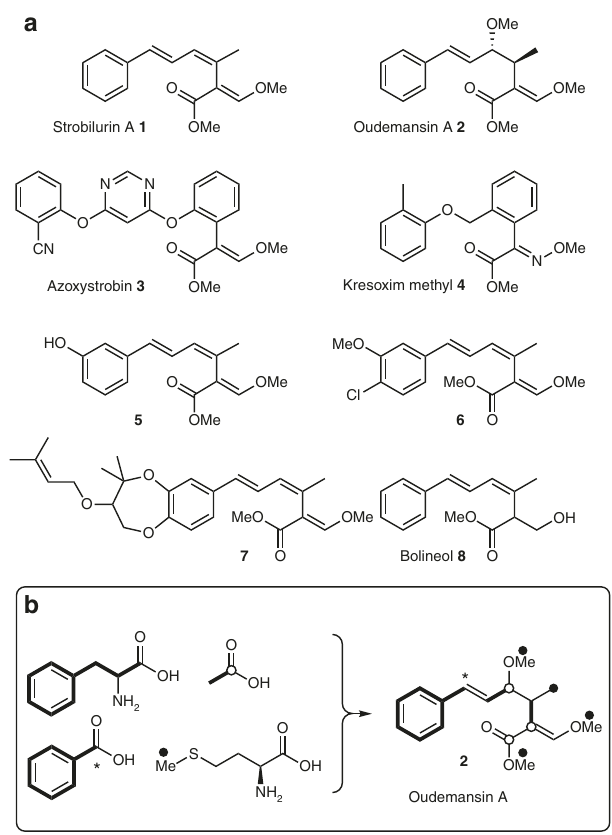
Fig. 1 Structures of key natural ( 1 , 2 , 5 – 8 ) and synthetic ( 3 , 4 ) strobilurins. a Compounds 1 – 3 and 5 – 7 feature the key β -methoxyacrylate toxophore, while 8 is reduced. Compound 4 possesses a chemically similar methoxyiminoacetate toxophore; b incorporation of biosynthetic precursors into oudemansin A. Origin of atoms as indicated by bold bonds, and open and closed